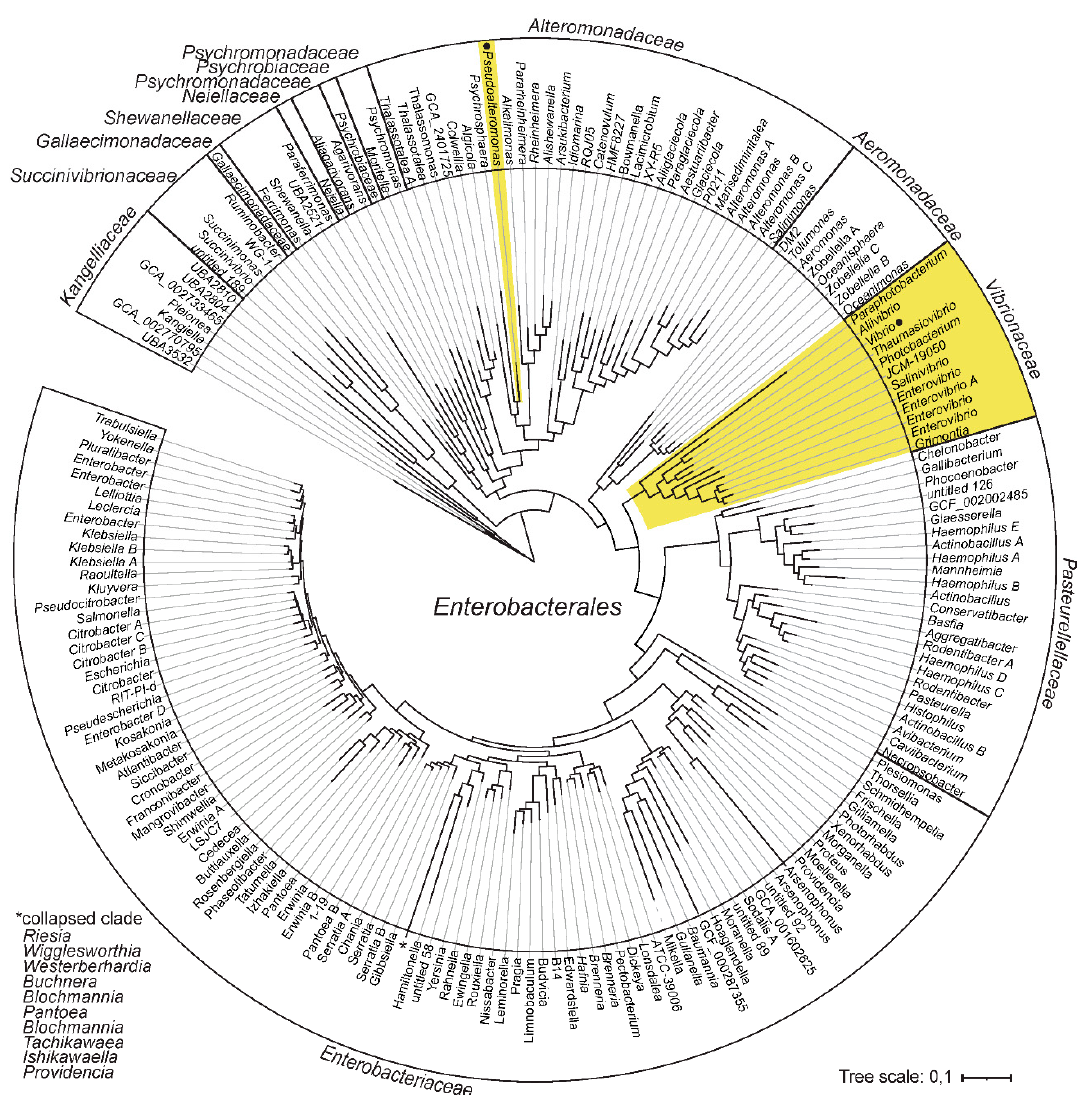
Figure 1. Phylogeny and distribution of bipartite genomes within Enterobacterales . Phylogenetic relationship between bacterial families and their respective genera are derived from the Genome Taxonomy database (GTDB). Lineages with bipartite genomes are highlighted in yellow, and genera investigated in this study are indicated with black dots.